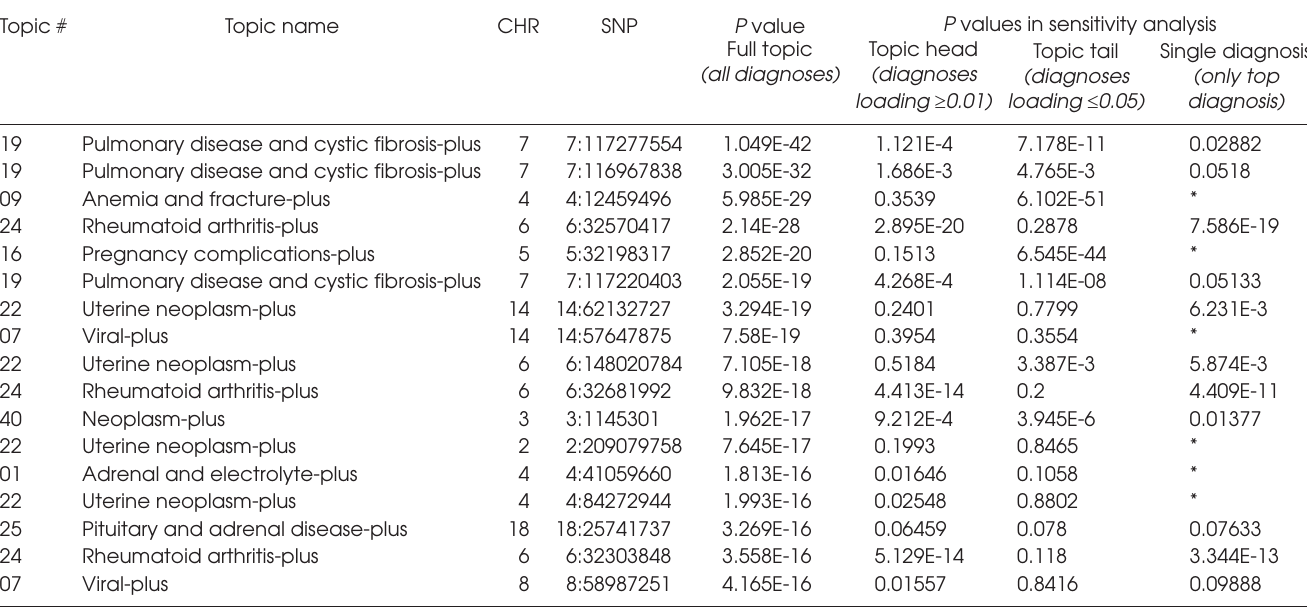
Table 3. Sensitivity analysis examining alternate phenotypes omitting the most- or least-strongly loading diagnoses Topic